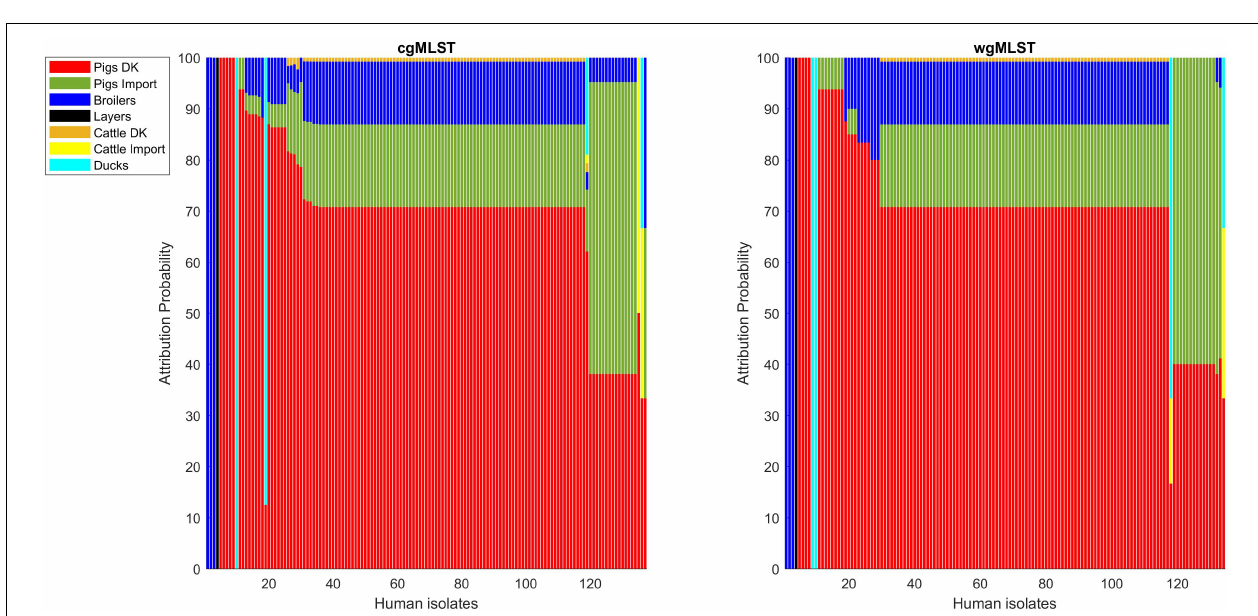
FIGURE 6 | Human isolate probability to originate from each source as determined by source attribution analysis via the network-based approach on the SNP pairwise distance matrix.